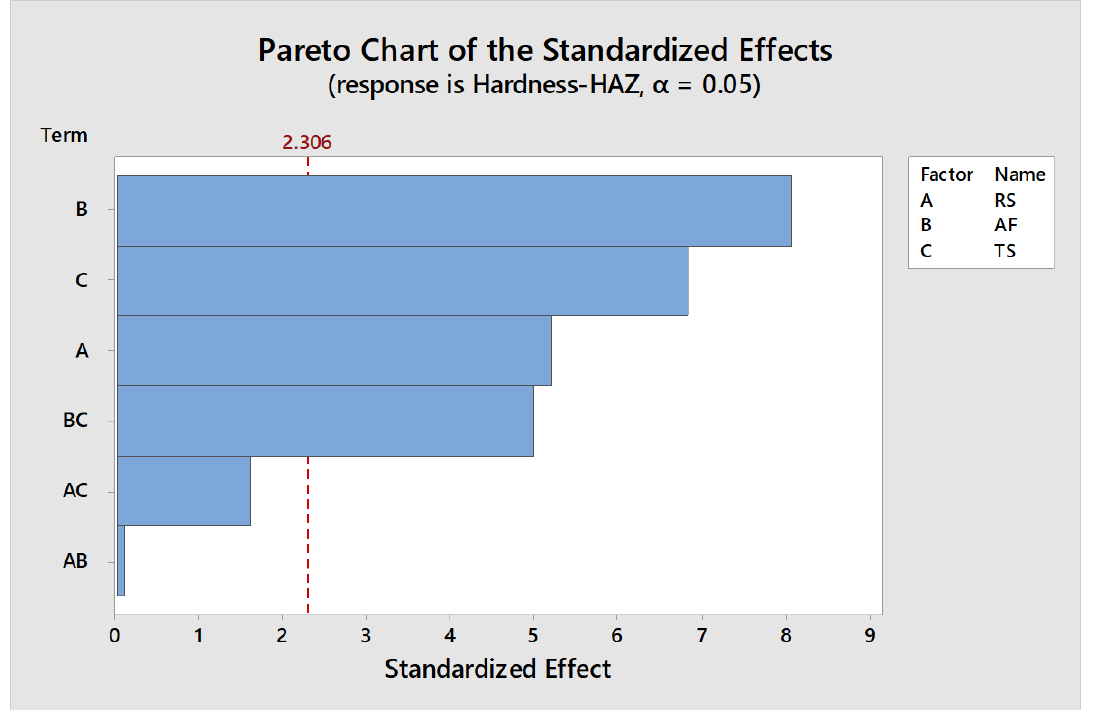
Figure 22. Pareto chart — hardness in HAZ.